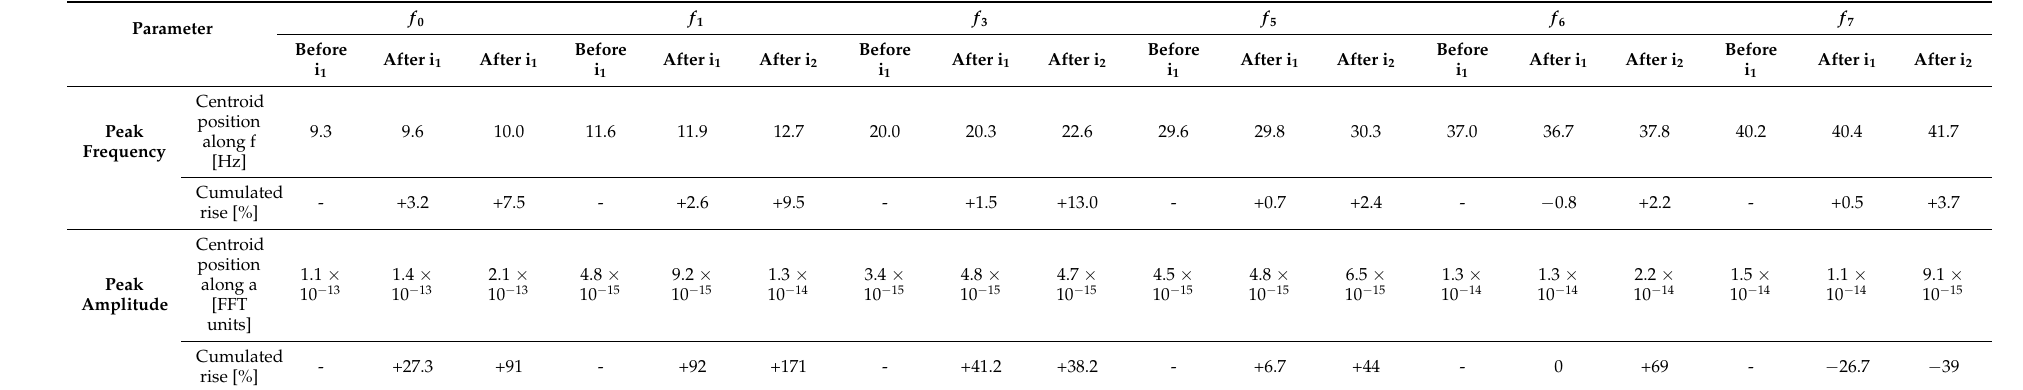
Table A2. FFT changes between bolting stages.